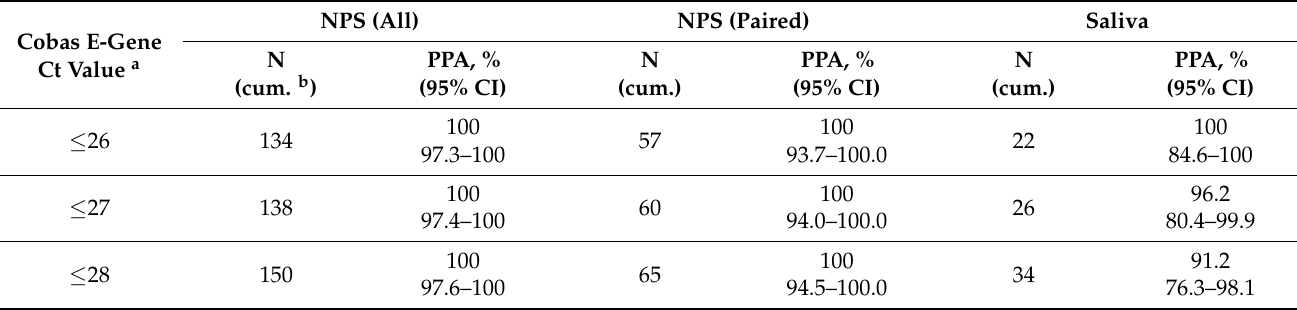
Table 2. Overview of positive percent agreement (PPA) of the Roche Elecsys Anti-SARS-CoV-2 Antigen assay with the Roche cobas SARS-CoV-2 IVD test in NPS and saliva. Cobas